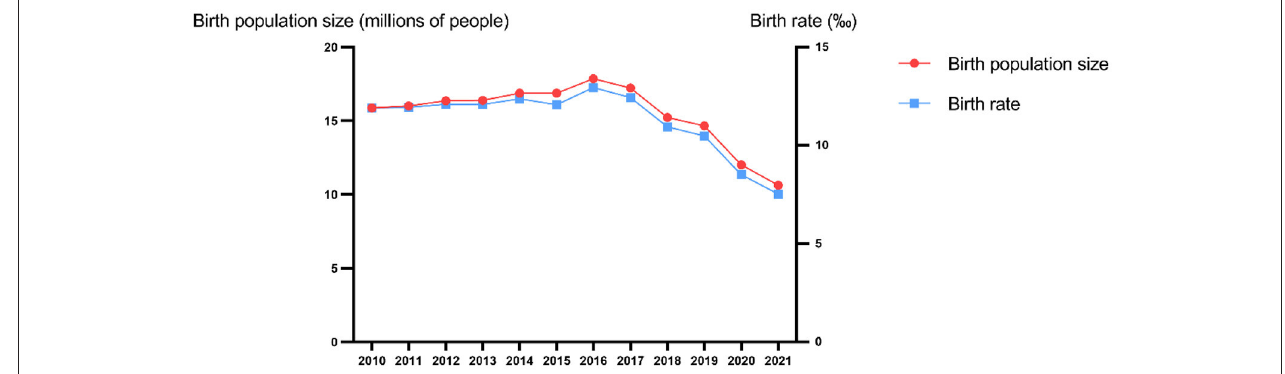
FIGURE 1 | The Birth Population Size and Birth Rate in China.